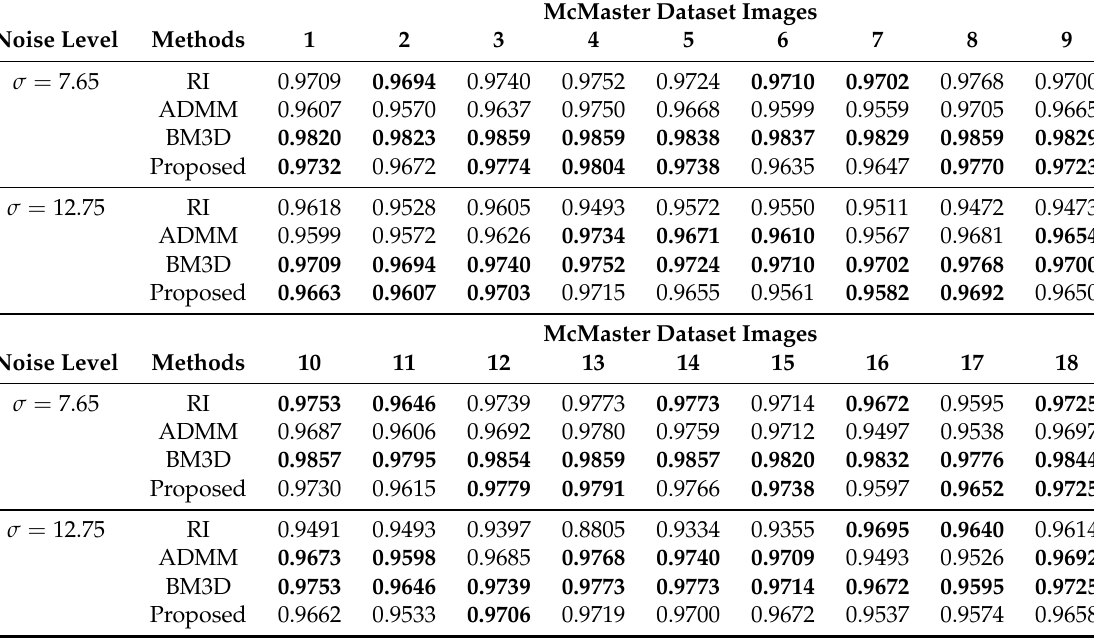
Table 2. Comparison of the FSIM between the different methods. The two best values are in bold